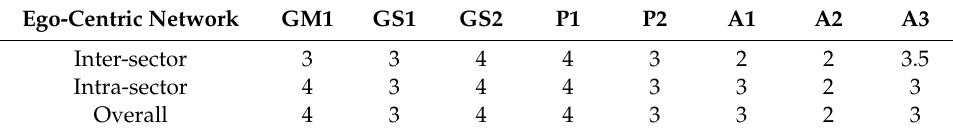
Table 5. Inter-sector versus intra-sector deliberation.